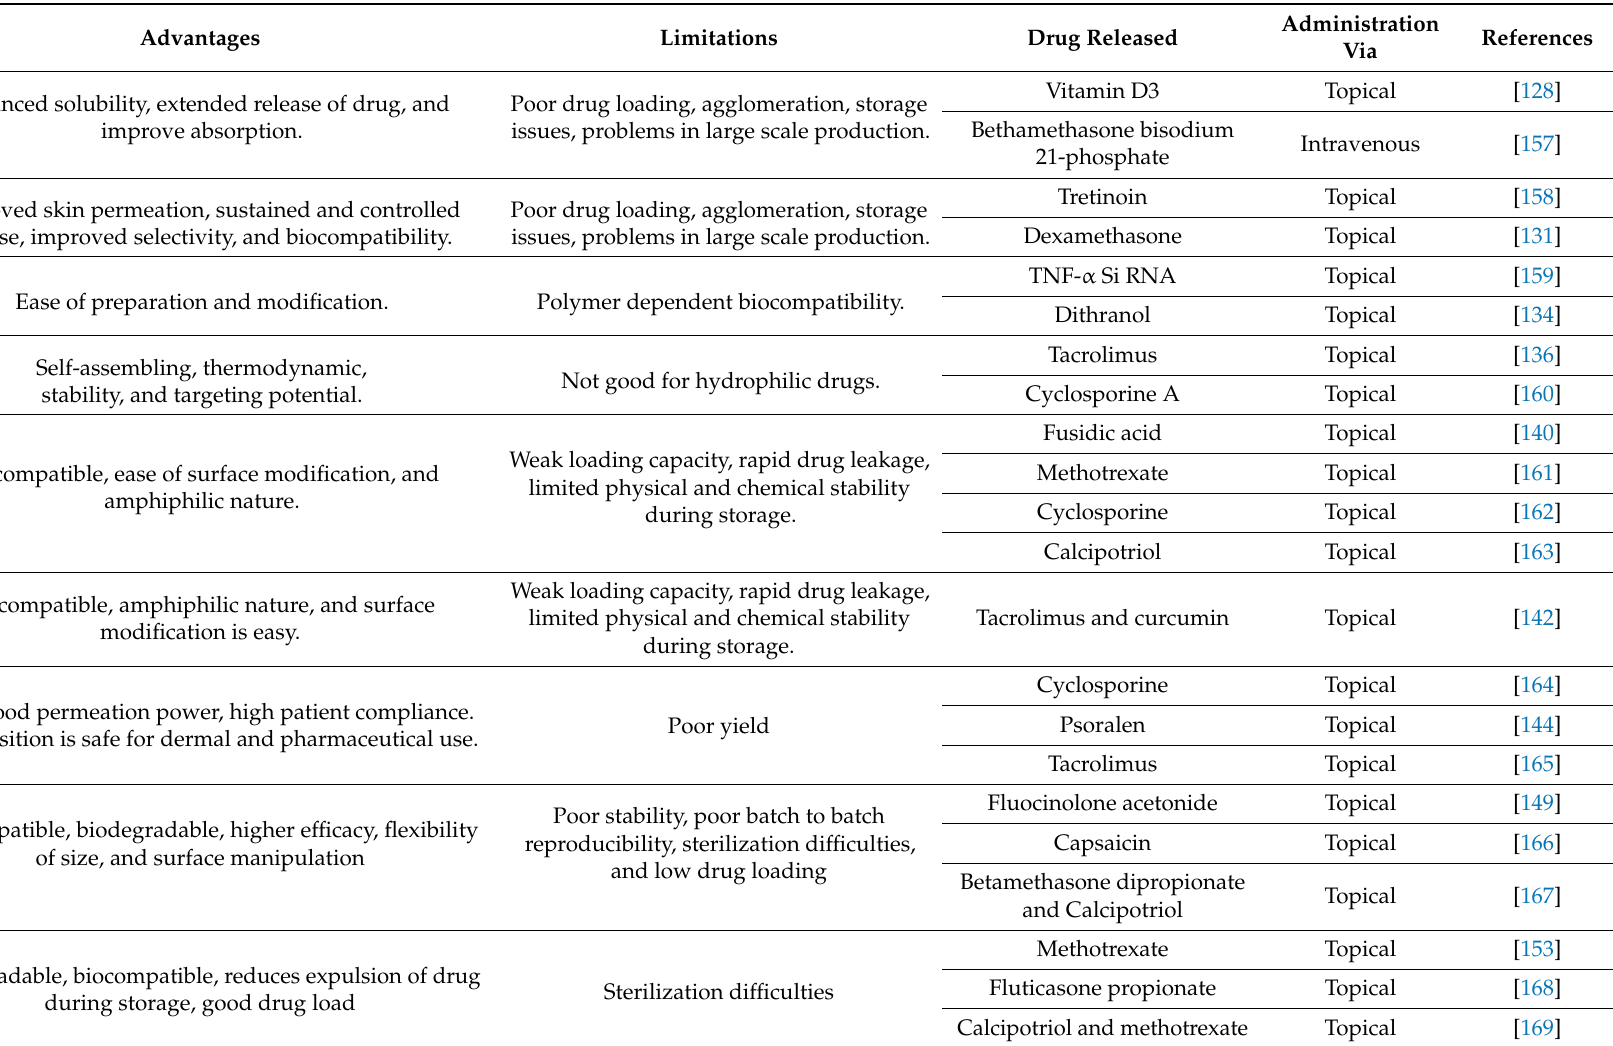
Table 4. Biodegradable nanotechnology-based treatments for